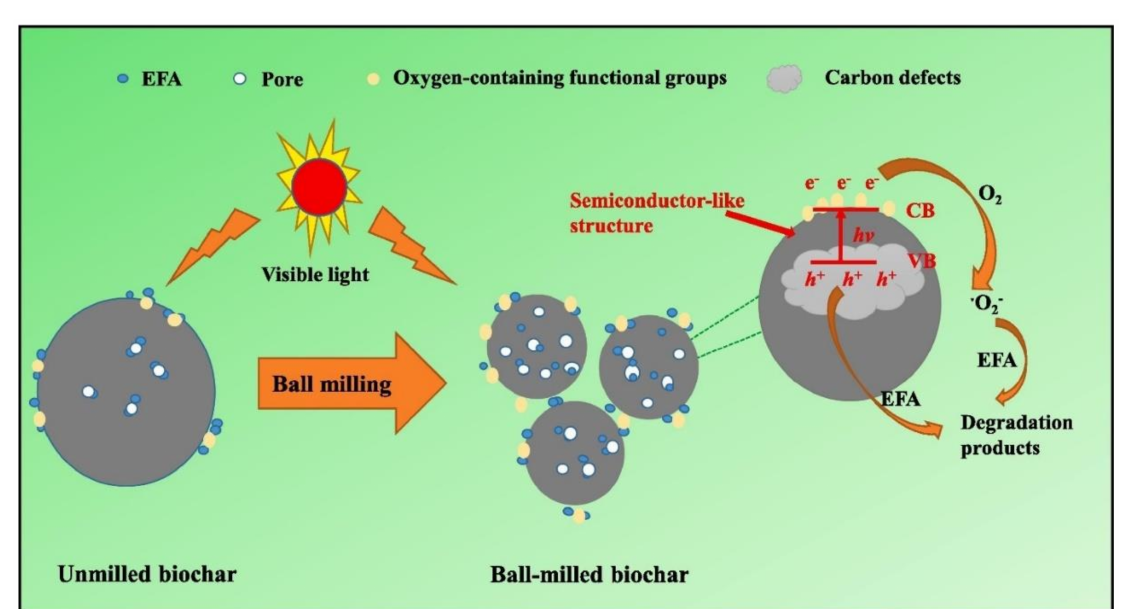
Figure 3. Mechanism of photocatalytic degradation of EFA by ball-milled biochar. Reprinted from Xiao et al. [112]. Copyright 2019, with permission from